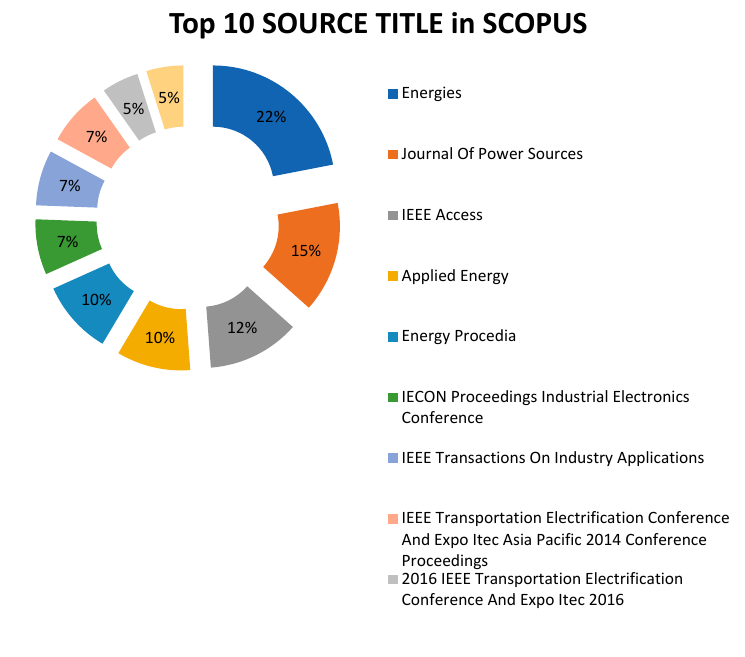
Figure 14. Top ten source titles in SCOPUS DB.